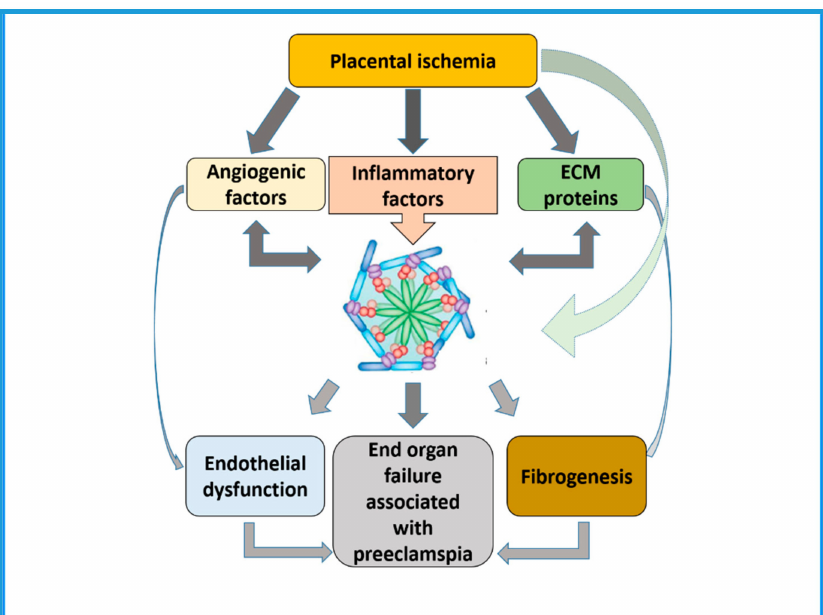
Figure 4. Summarizes the central role of inflammasomes in the pathogenesis of preeclampsia. Premature activation of inflammasomes following placental ischemia in preeclampsia a ff ected pregnancies may lead to changes in vascular structure and function and enhanced fibrosis contributing to end stage organ